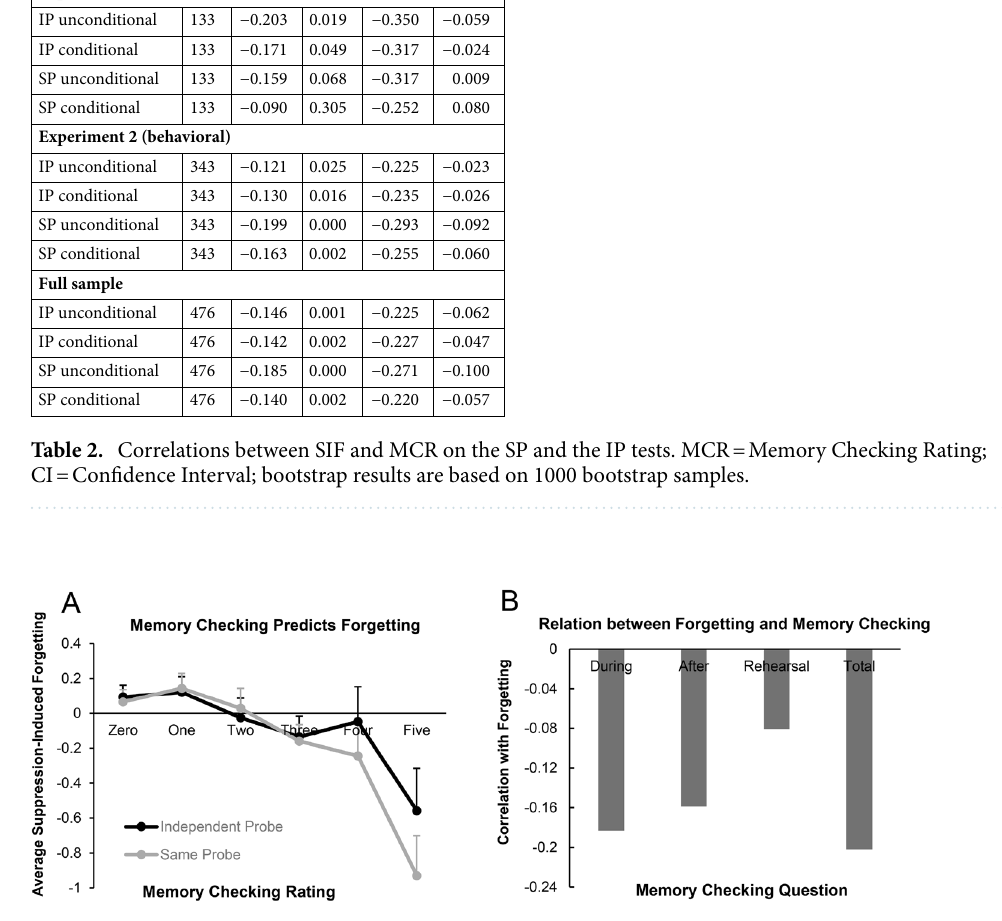
Figure 4. ( A ) The amount of suppression-induced forgetting observed for each level of memory checking reported, separately for the Same-Probe and Independent-Probe tests in the overall sample. Bars represent + standard errors. ( B ) Pearson correlations between SIF and intentional memory checking either during or after No-Think trials, intentional rehearsal of No-Think items, or total